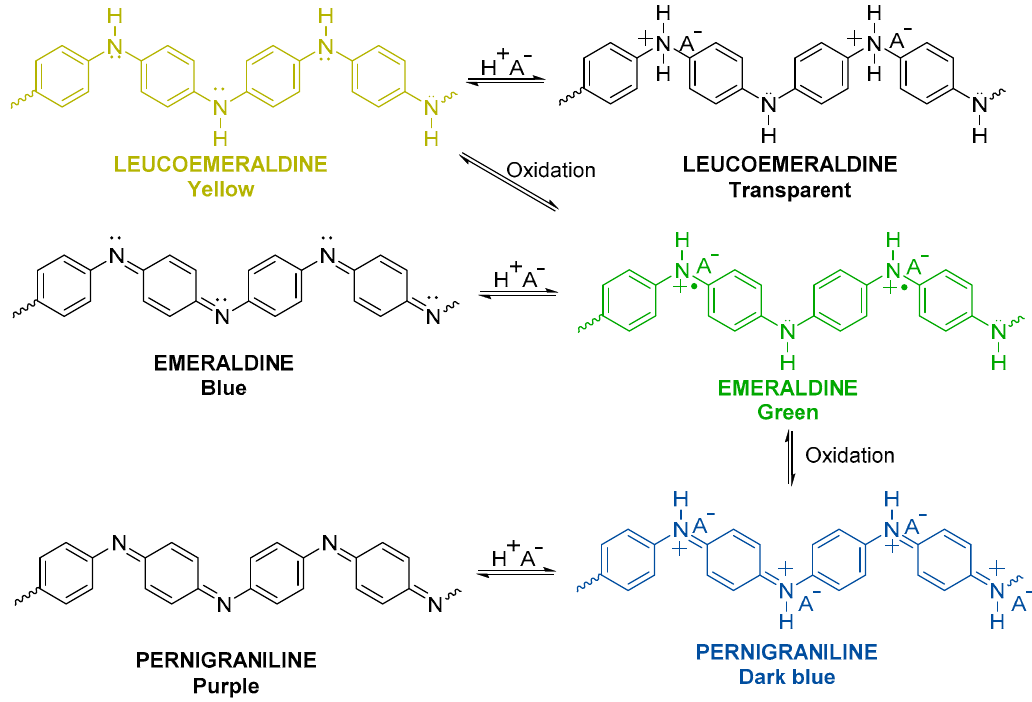
Scheme 2. Protonation/deprotonation and redox reactions between the discussed redox states of polyaniline.